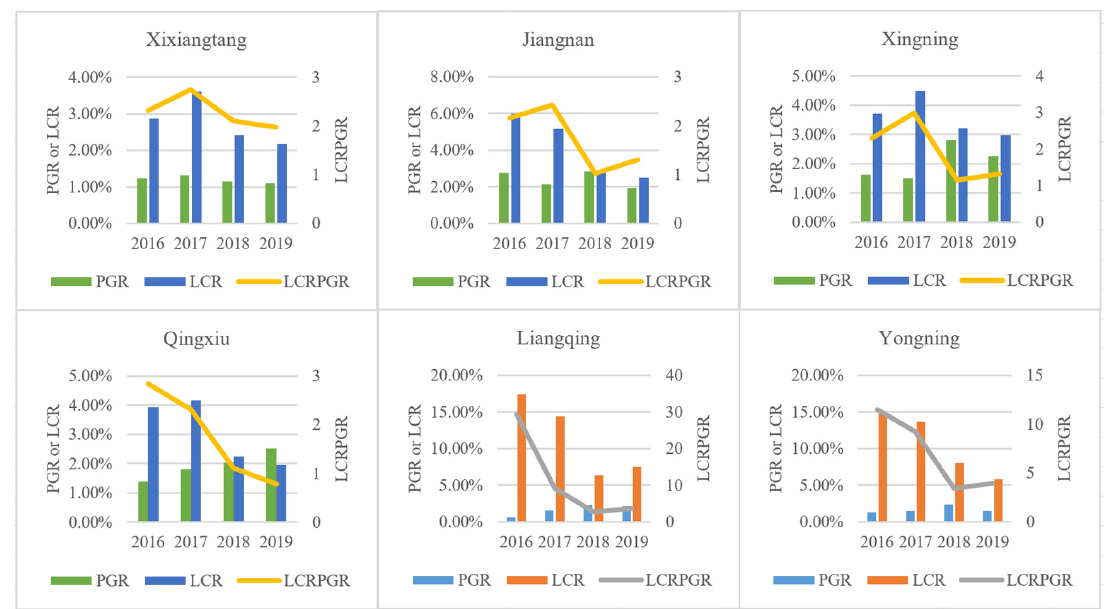
Figure 8. Curve of LCRPGR of each district in Nanning from 2016 to 2019.